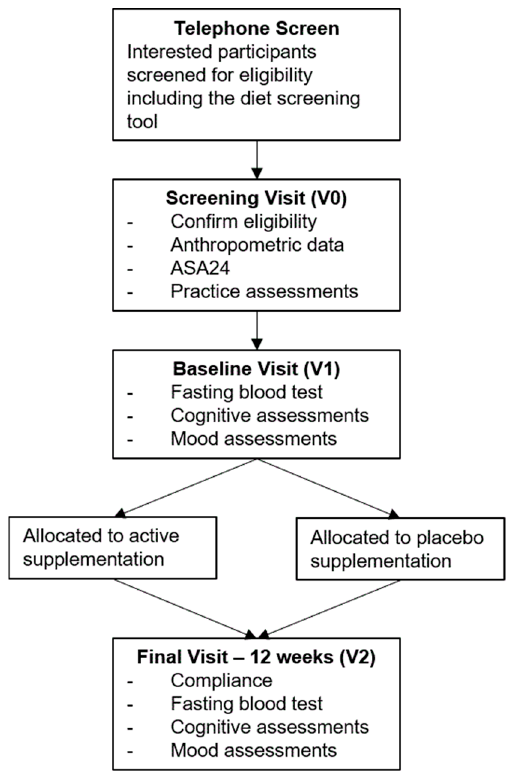
Figure 2. Outline of Study